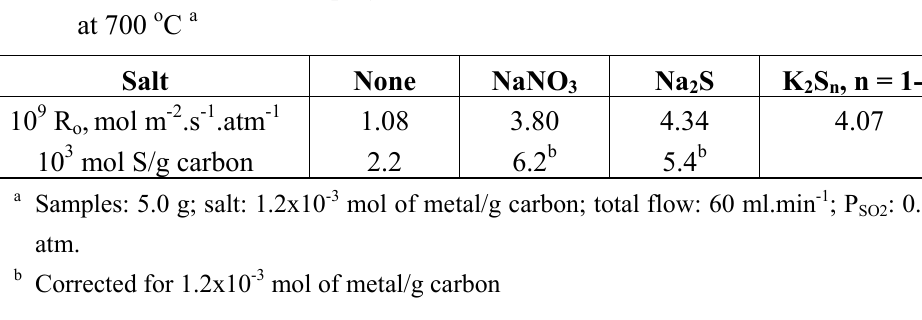
Table 4 . Effect of sulfides and polysulfides on the reaction of activated carbon with SO